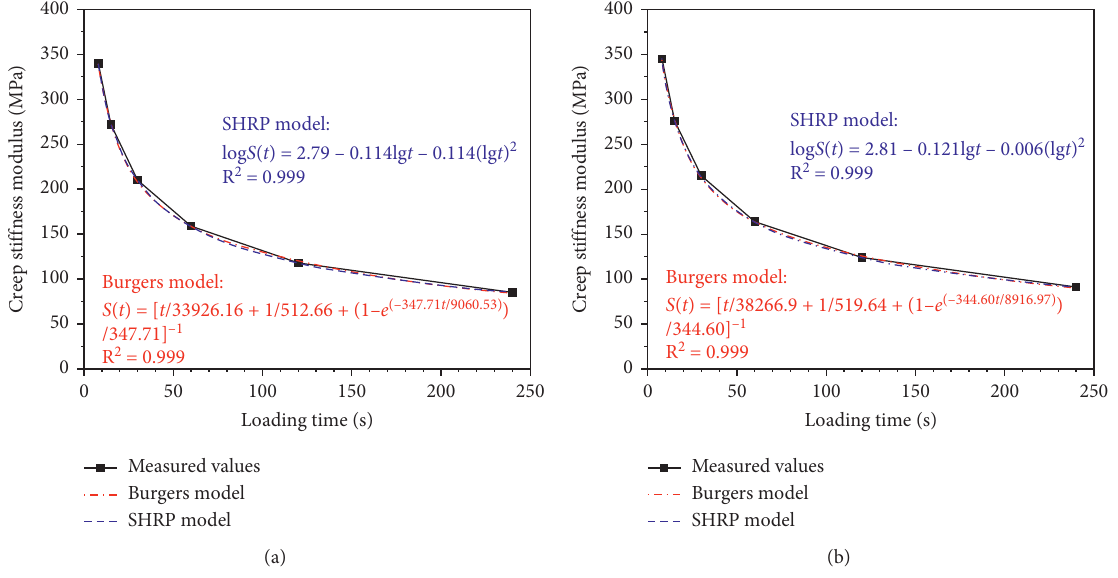
Figure 11: Rheological models of bitumen. (a) Base bitumen and (b) nano-TiO